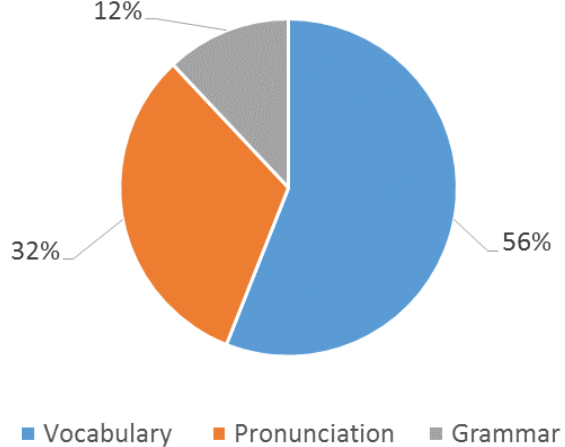
Figure 7: Level of appropriateness of learning material via mobile